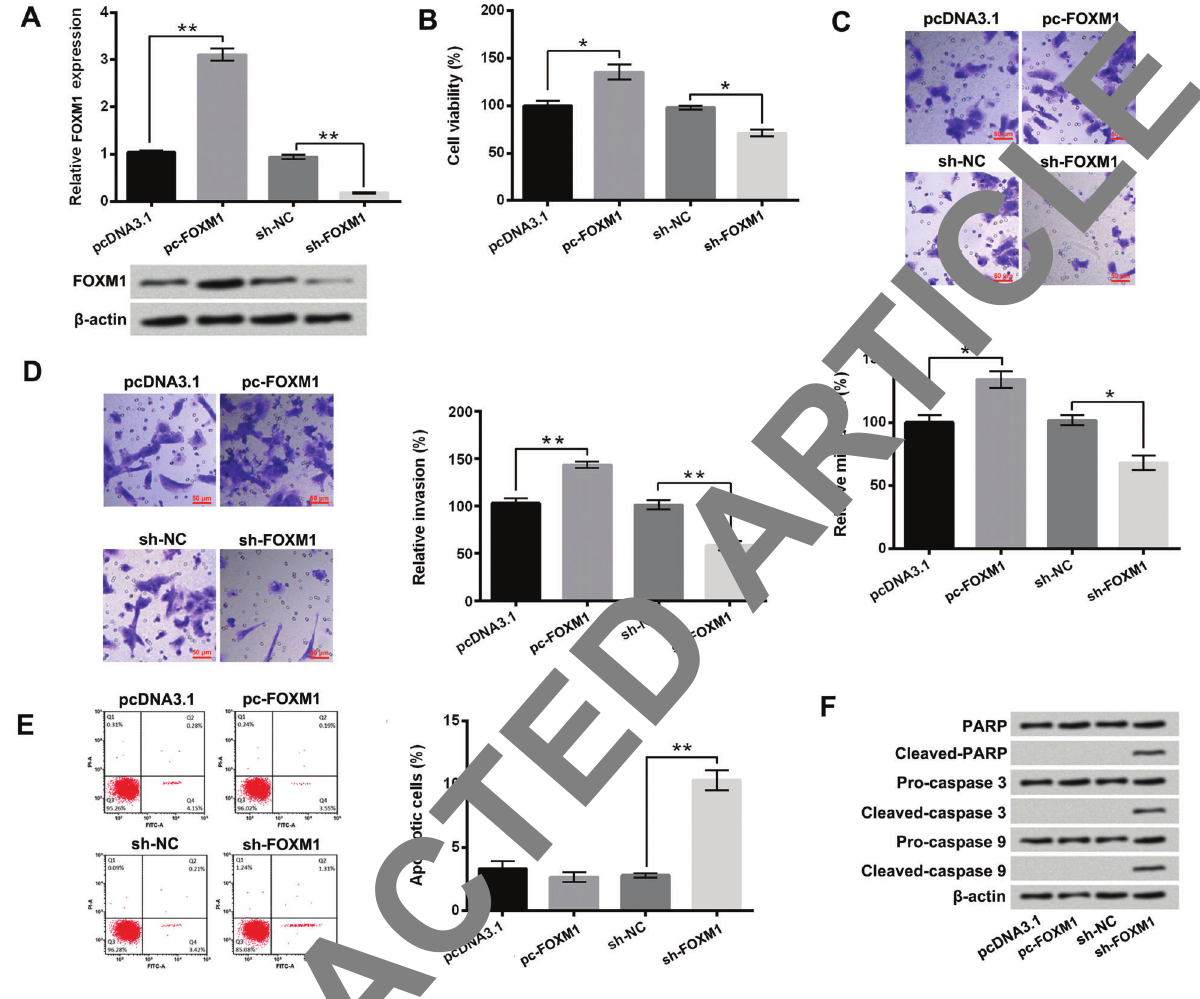
Figure 6. After pc-FOXM1 or sh-FOXM1 transfection, A , the mRNA and protein levels of FOXM1, B – E , the viability, migration, invasion, and apoptosis of GH3 cells, and F , the expression levels of PARP, cleaved-PARP, pro-caspase 3, cleaved-caspase 3, pro-caspase 9, and cleaved-caspase 9 in GH3 cells were assessed using qRT-PCR, western blotting, trypan blue staining assay, two-chamber transwell assay, and Guava Nexin assay. FOXM1: Forkhead box protein M1; NC: negative control; PARP: poly ADP-ribose polymerase. Data are reported as means ± SD. *P o 0.05; **P o 0.01